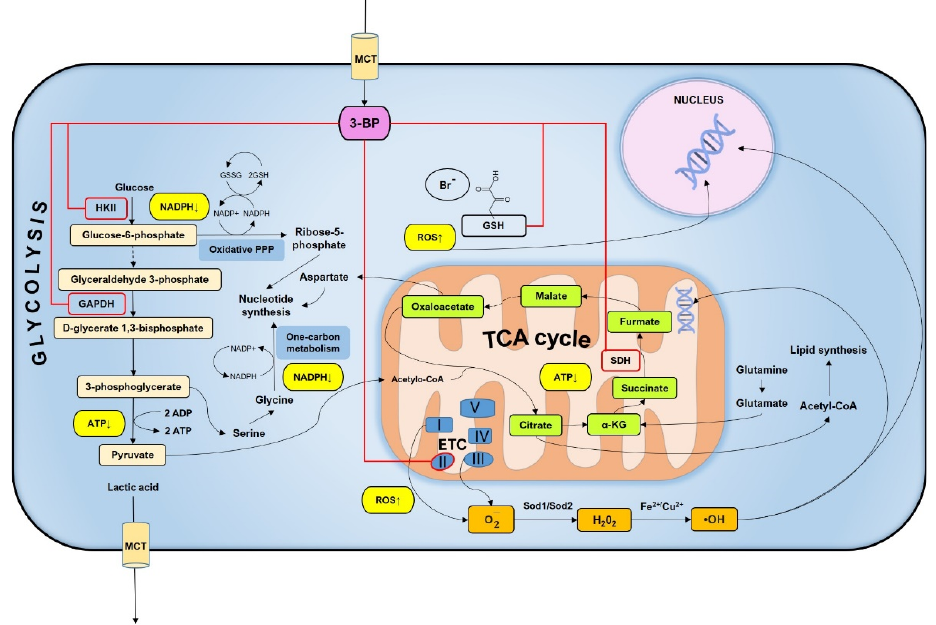
Figure 8. Possible mechanisms of 3 ‐ BP ʹ s killing actions to cells. After entering the cell through MCTs’ channels, 3 ‐ BP inhibits glycolytic enzymes (i.e., HK2, GAPDH) and mitochondrial oxidative phosphorylation pathway (i.e., complex II/SDH). Additionally, 3 ‐ BP leads to a reduction in the amount of glutathione while increasing the level of ROS. By disrupting the mitochondrial electron transport chain, 3 ‐ BP leads to the generation of mitochondrial ‐ dependent ROS, which results in mtDNA damage. Excess ROS may potentially induce damage to genomic DNA.